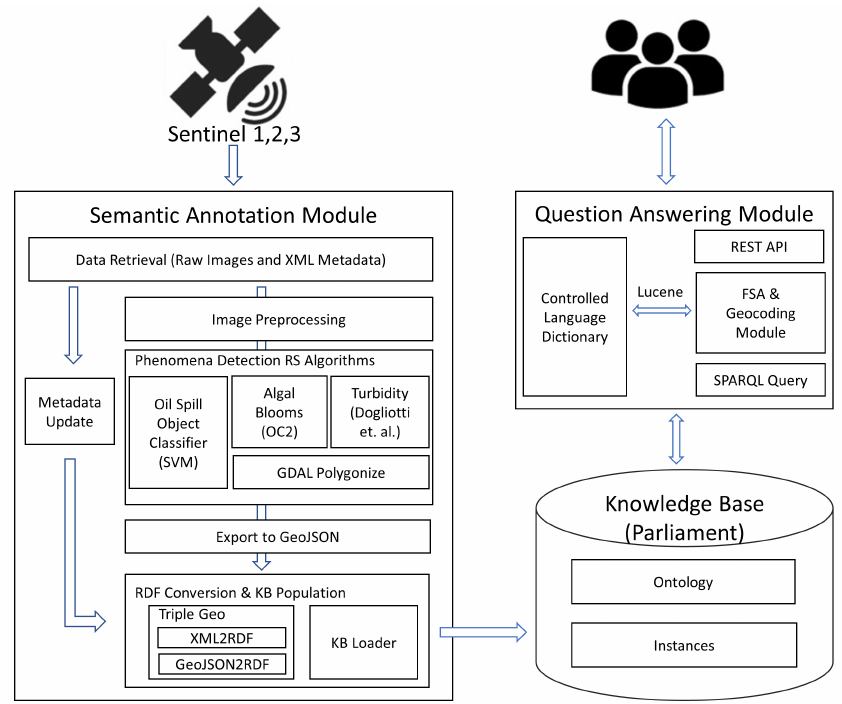
Figure 5. SeMaRe system